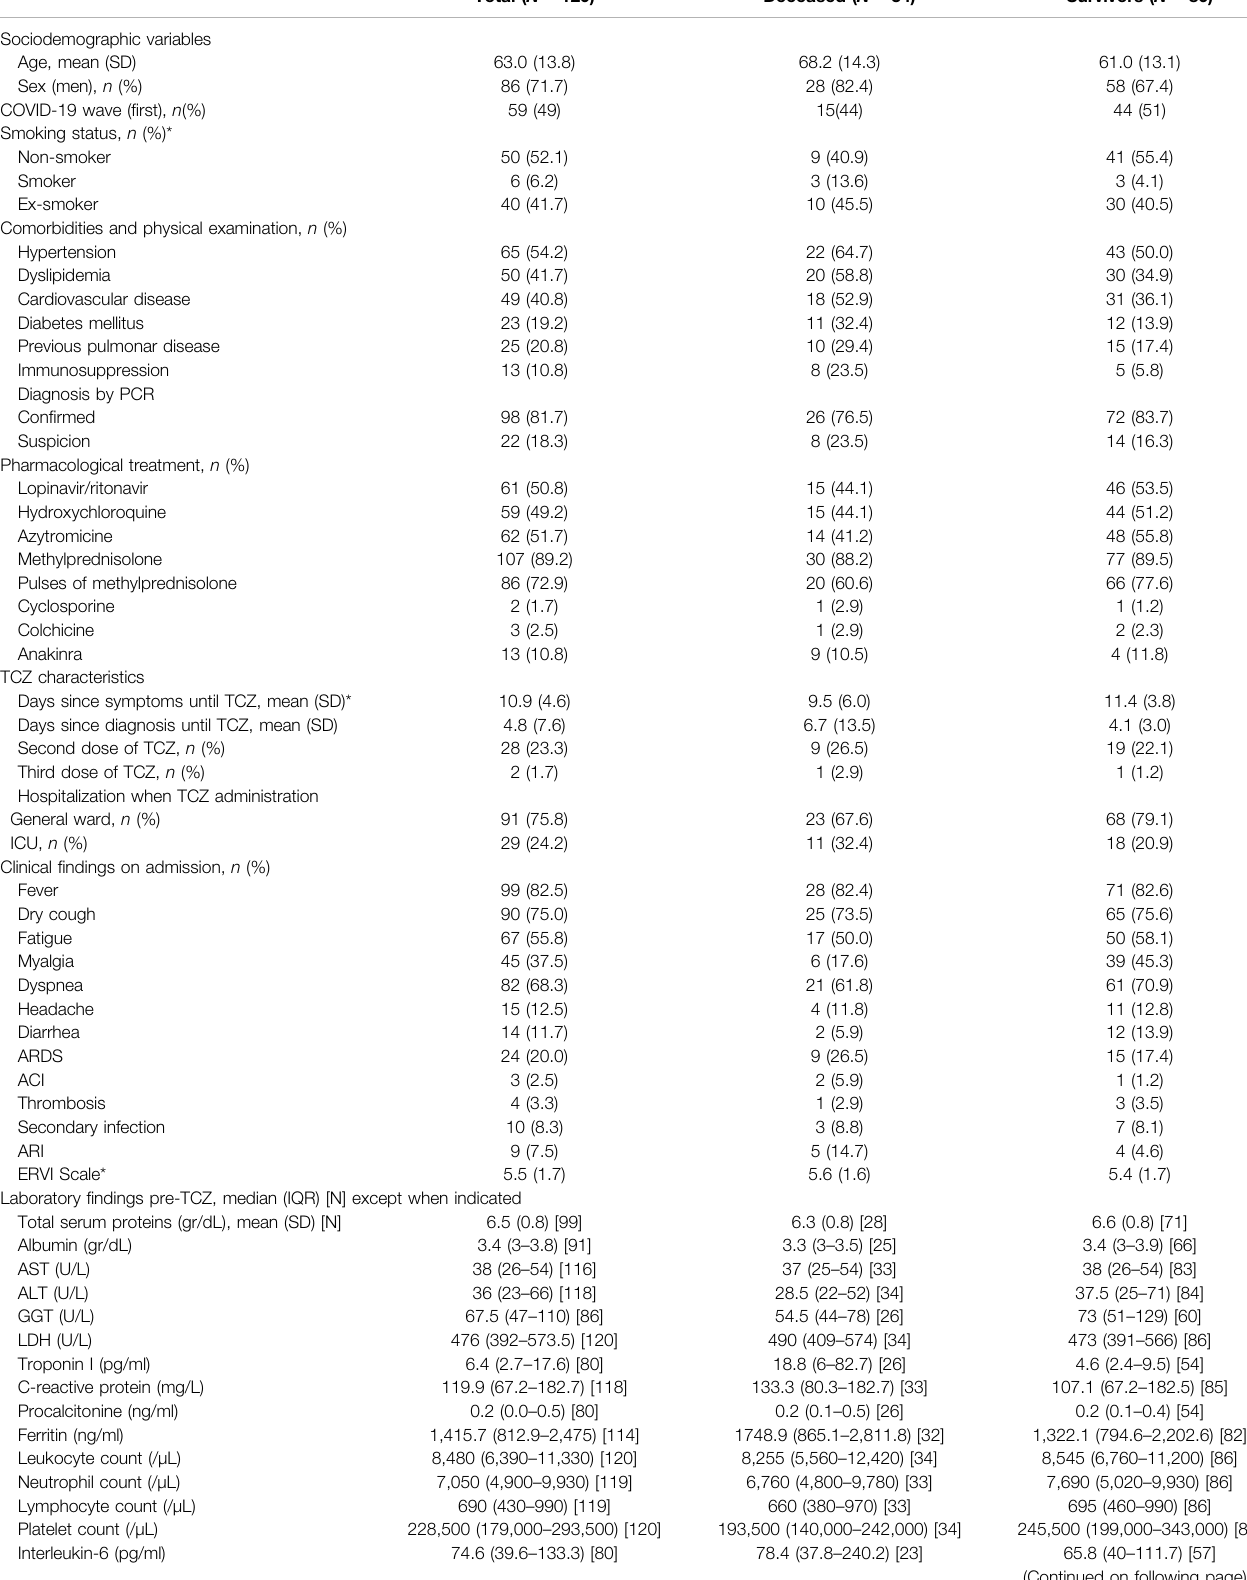
TABLE 1 | Baseline demographic, clinical, pharmacological and laboratory data of patients diagnosed with COVID-19 receiving